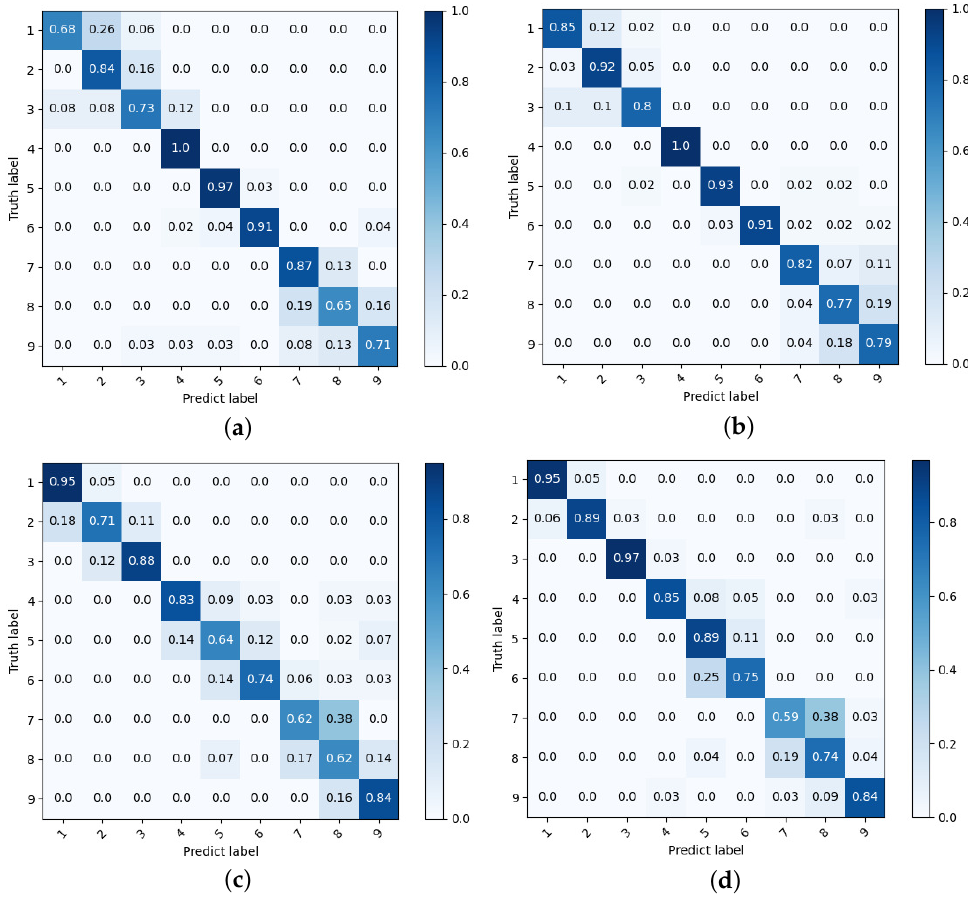
Figure 4. Confusion matrix of CM-NET (Training without image) and CM-NET test results. In the confusion matrix, the row coordinates represent the number of people predicted by the network and the vertical coordinates represent the actual number of people; the numbers in the matrix represent the proportion of correctly predicted samples to the total samples in the class. ( a ) CM-NET (Training without image) confusion matrix on dataset-1. ( b ) CM-NET confusion matrix on dataset-1. ( c ) CM-NET (Training without image) confusion matrix on dataset-2. ( d ) CM-NET confusion matrix on